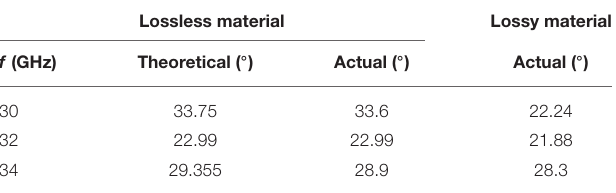
TABLE 3 | The deflection angles of six elements with a lossless and lossy at different